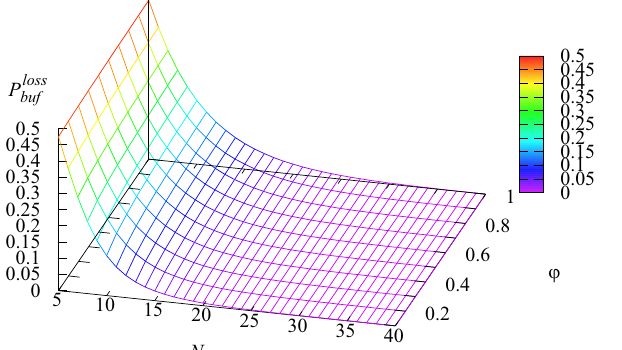
of an arbitrary request from the main buffer on ϕ buf